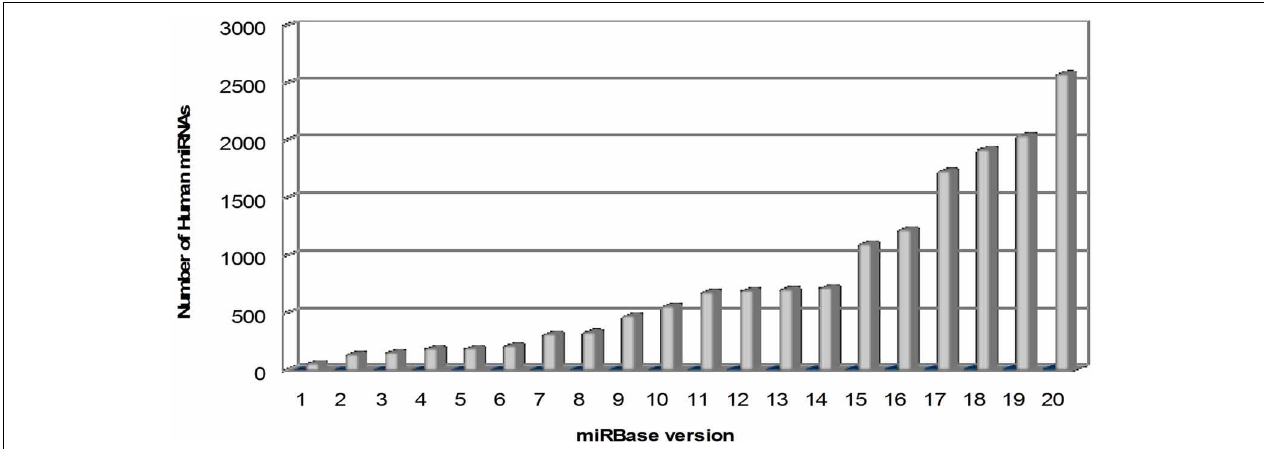
FIGURE 1 | Overtime trend in the number of human microRNAs annotated in miRBase. The number of mature human microRNAs annotated in miRBase database (Kozomara and Griffiths-Jones, 2014;